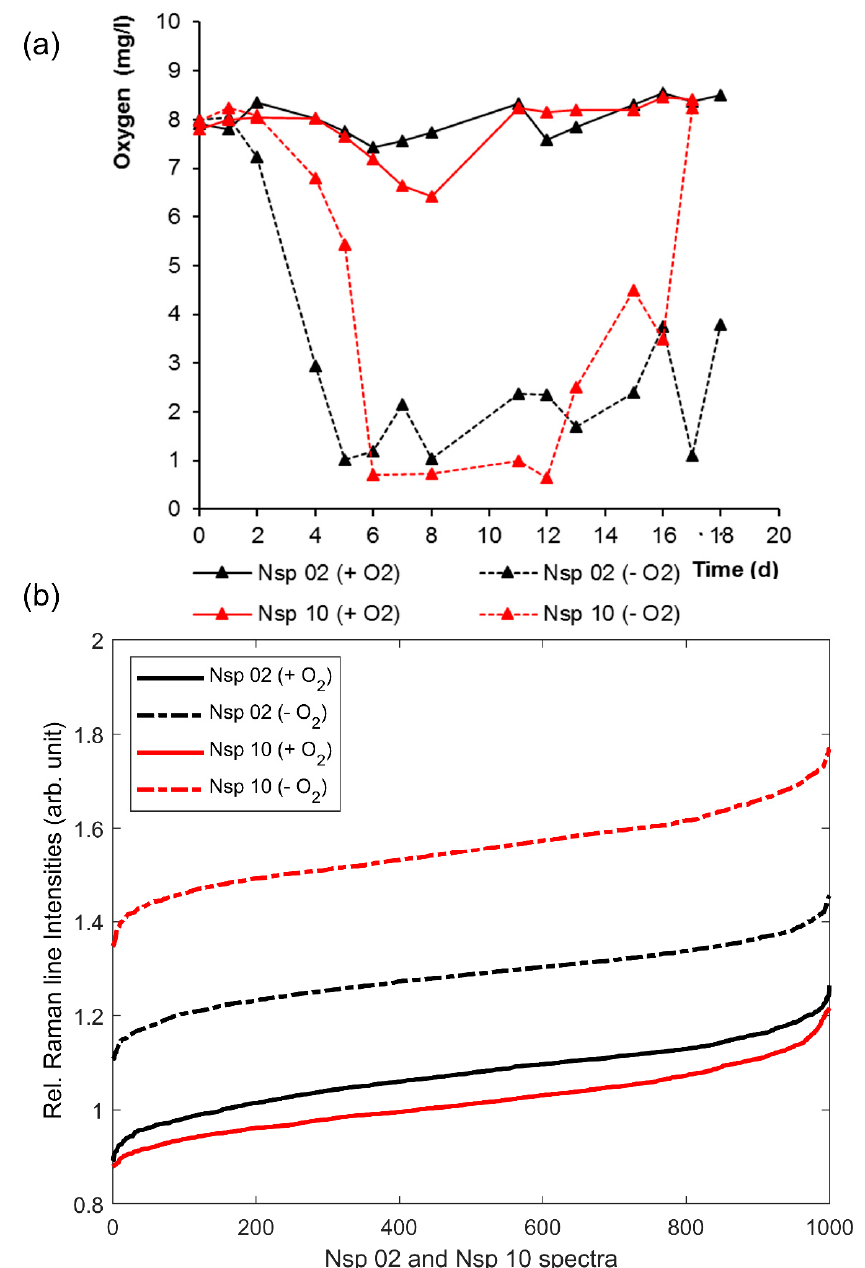
Figure 4. Oxygenation history ( a ) and relative Raman line intensities (relRI) sorted in ascending order of 1000 random cells each ( b ) of Nitrosospira sp. (Nsp 02) (black) and Nitrosospira briensis (Nsp 10) (red) grown under well-aerated (solid) or oxygen-deprived (dashed) conditions. The elevated cytochrome c activity of oxygen-deprived N. eutropha and Nitrosospira fit well with